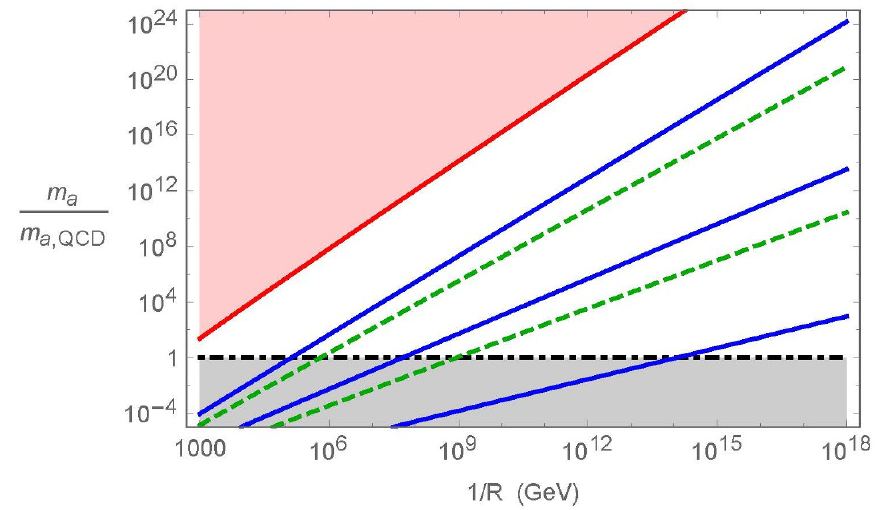
Figure 4 . The axion mass ratio for the boundary fermions case (assuming (cid:11) s ( m Z ) = 0 : 118), as a function of 1 =R for various contours of (cid:15) = (0 : 3 ; 0 : 25 ; 0 : 2) (top to bottom). The solid lines are the exact results obtained from a numerical integration of (2.8) and no higher dimension terms ( c 6 = 0). The green dashed line represents the addition of the higher dimension term (2.11) with c 6 = 0 : 5 and (cid:15) = 0 : 52 (0 : 47) for the upper (lower) line. The red line depicts the maximum enhancement in the strong coupling limit using m a; 5 f